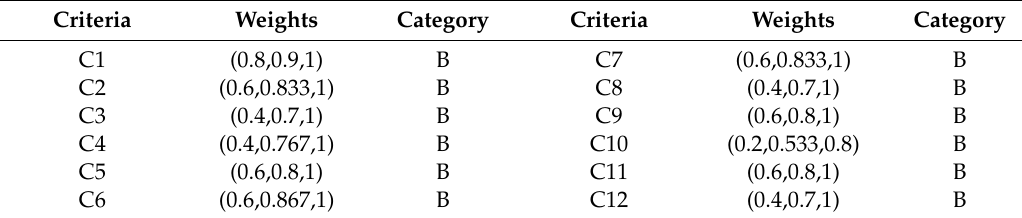
Table 11. The category of each criterion.